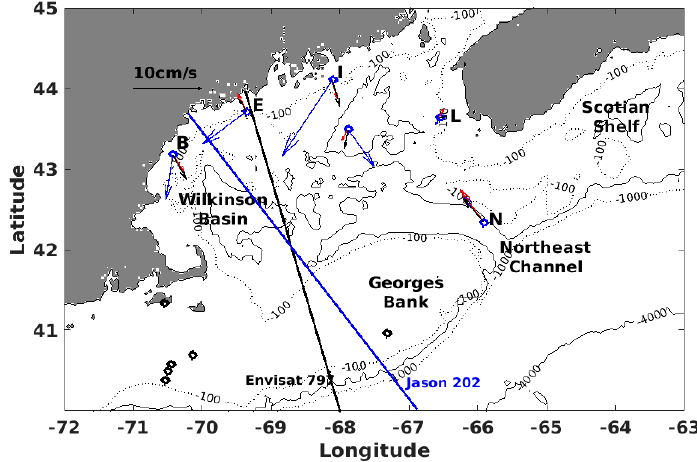
Figure 2. Mean upper ocean current vectors for both in situ ADCP current measurements and GlobCurrent products on the Northwest Atlantic shelf in the GoM. In situ data are depth-averaged mean current vectors U DA15m in blue while GlobCurrent vector currents U G (Geostrophic only) are in red and U GE15m (Geostrophic and 15 m Ekman) are in black. Two satellite altimeter tracks (Envisat track E797, Jason track J202) are also shown.